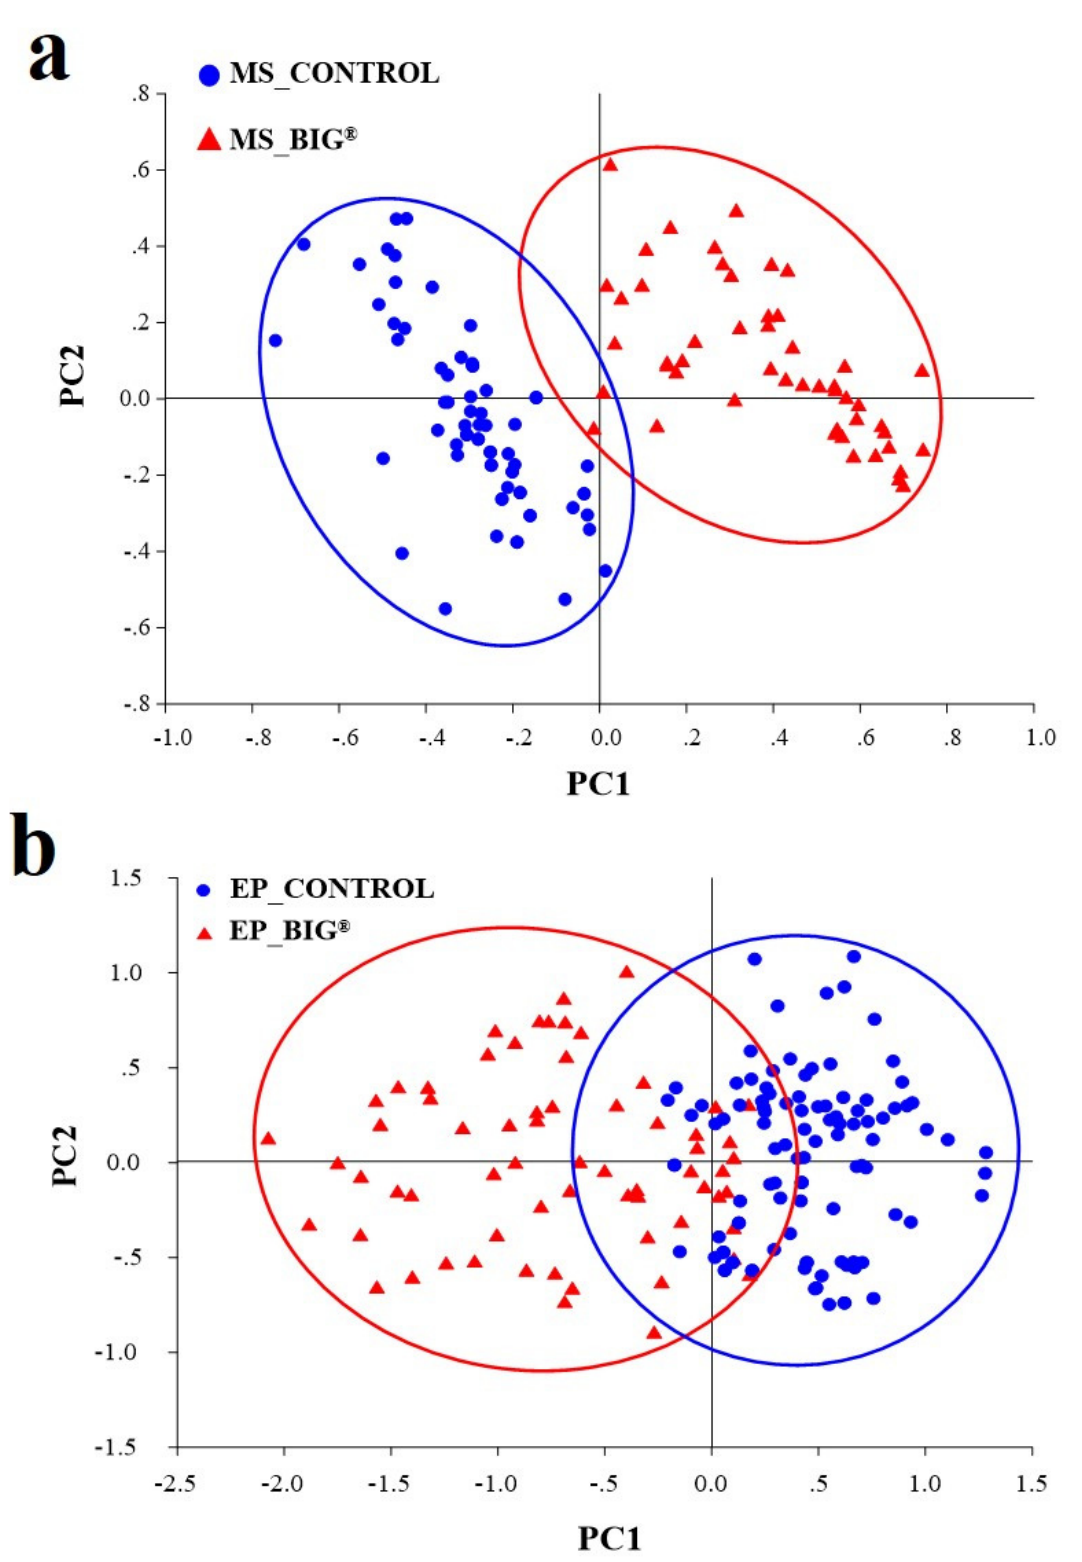
Figure 6. PCA analysis of the mesophyll and epidermis on rice leaves of cv. KDML 105 in response to an inoculation challenge with Xoo at 14 DAI under greenhouse conditions. ( a ) Mesophyll of rice plants after inoculation challenge with BIG ® compared with the control. ( b ) Epidermis of rice plants after inoculation challenge with BIG ® compared with the